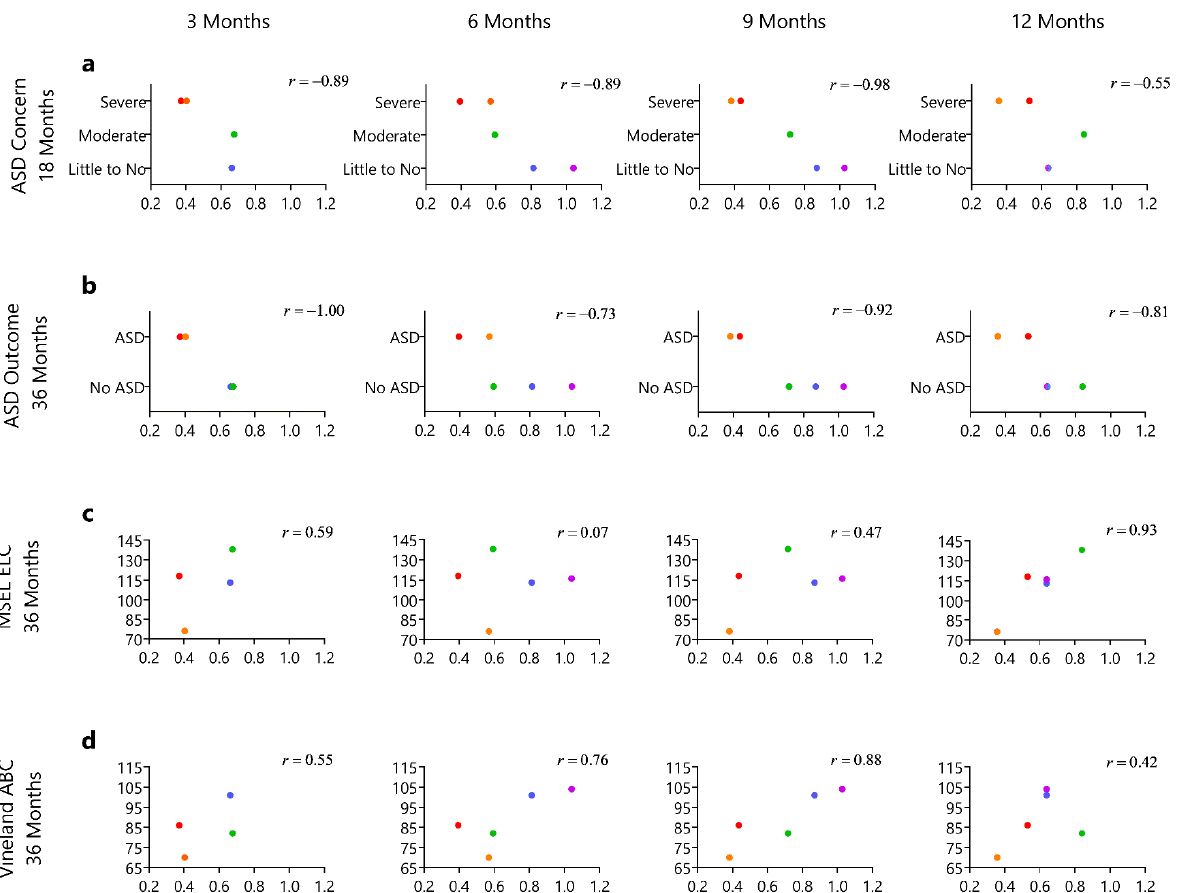
Figure 3. The following series of graphs represents the developmental outcome on the y -axis by visit level motion complexity score on the x -axis at 3, 6, 9, and 12 months of age. ( a ) The y -axis represents Autism Spectrum Disorder (ASD) concern at 18 months of age indicated by severe concern, moderate concern, and little to no concern. ( b )The y -axis represents Autism Spectrum Diagnosis at 36 months of age (diagnostic outcome assessment) as indicated by diagnosis of ASD and No ASD. ( c ) The y -axis represents the cognitive ability as measured by the Mullen Scales of Early Learning (MSEL), Early Learning Composite. ( d ) The y -axis represents adaptive skills as measures by the Vineland Adaptive Behavioral Scale-II, Adaptive Behavior Composite.